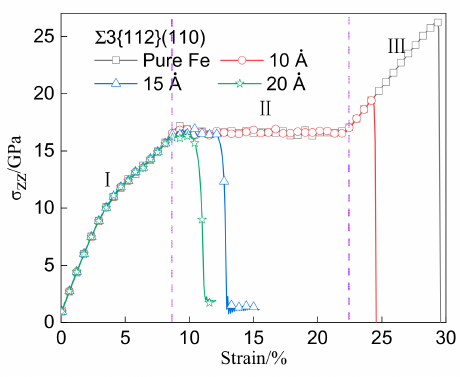
Figure 6. Stress–strain diagram of {112} grain boundary with no Cu clusters and with Cu clusters of di ff erent sizes.